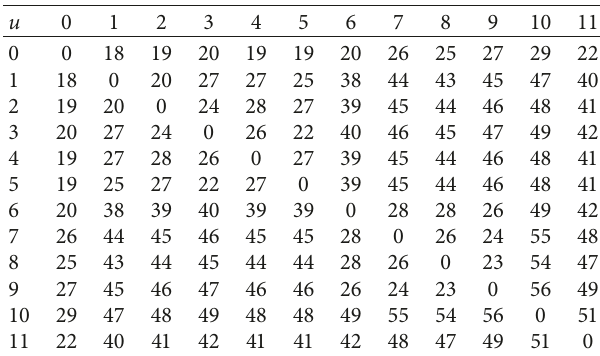
Figure 10: Hybrid siding network in railway terminal. Table 1: Travel time of shunting engine between a pair of handling stations in railway terminal (unit: min).